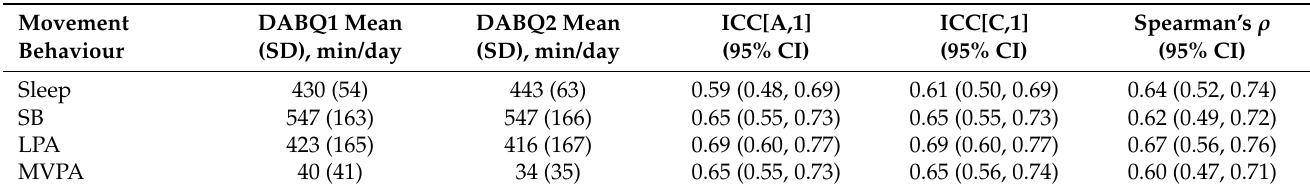
Table 2. Test-retest reliability of the Daily Activity Behaviours Questionnaire